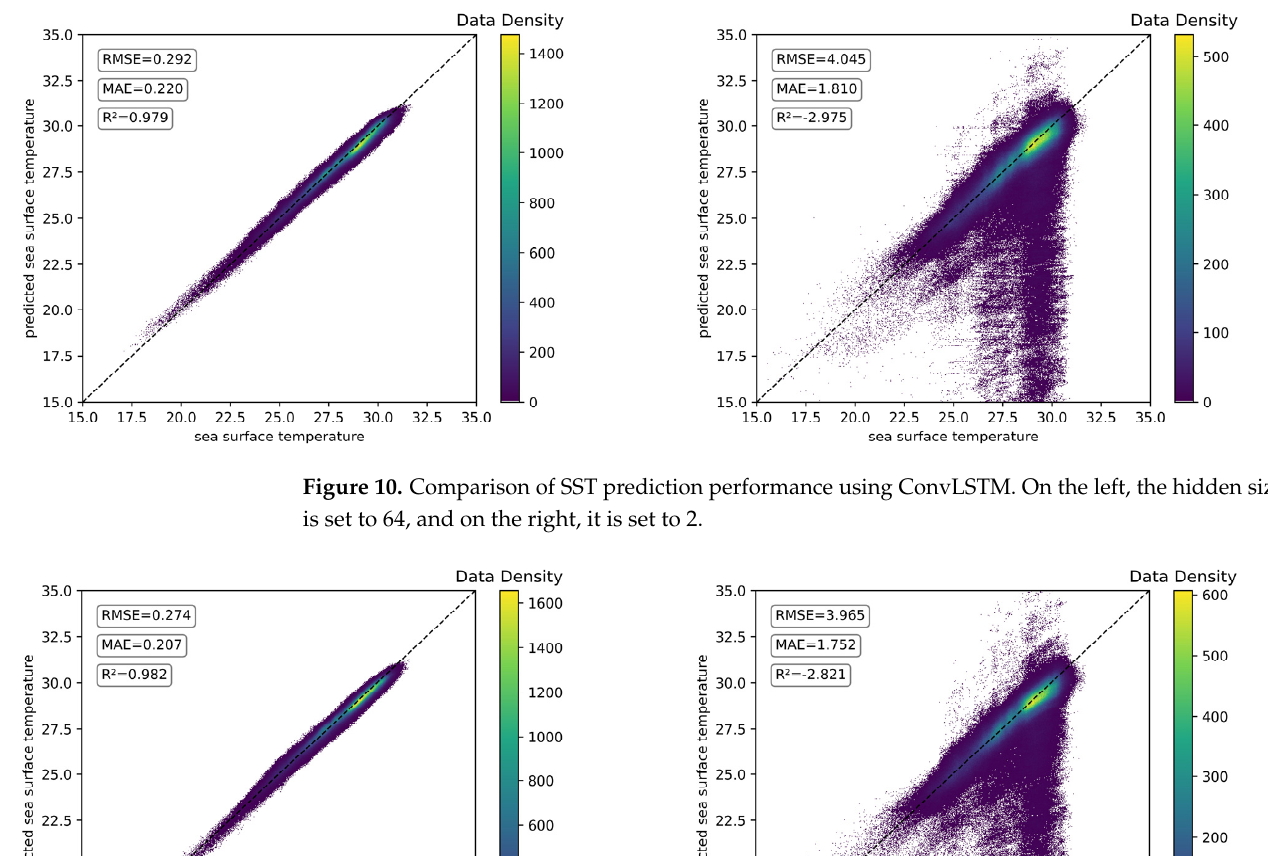
Table 6. The prediction result of SST (Maximum Error and Minimum Error).